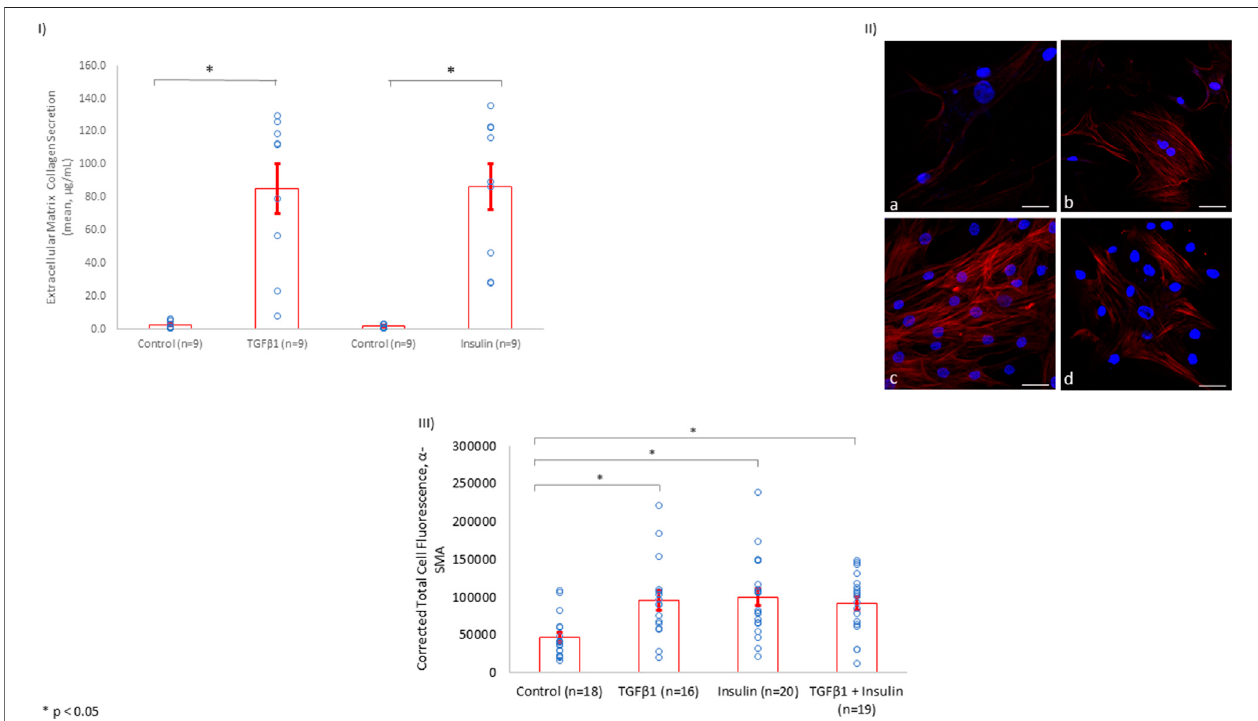
FIGURE4| InsulinInducesCollagenSecretionand α -SMAExpressiontoLevelsSimilartoTGF β 1inHCF. (I) Similartothe fi ndingsinratLVtissue,insulintreatment (10 nmol/L) induced extracellular collagen secretion to a comparable degree with the known fi brosis-inducing agent, TGF β 1 (5 ng/ml). (II) Using total cell immuno fl uorescence, α -SMA levels were inspected among control HCF simply incubated in culture media for 72 h (a). α -SMA levels were upregulated after HCF incubation with TGF β 1 (5 ng/ml) (b), insulin (10 nmol/L) (c), or insulin (10 nmol/L) + TGF β 1 (5 ng/ml) (d) for 72 h in culture media (Scale bar: 50 µm). (III) Quanti fi cation of the of α -SMA expression levels using immuno fl uorescence in HCF among controls, HCF with TGF β 1, HCF with insulin, and HCF with insulin + TGF β 1.